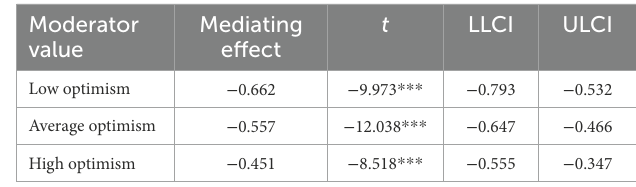
TABLE 5 Mediating effect of perceived stress conditional on